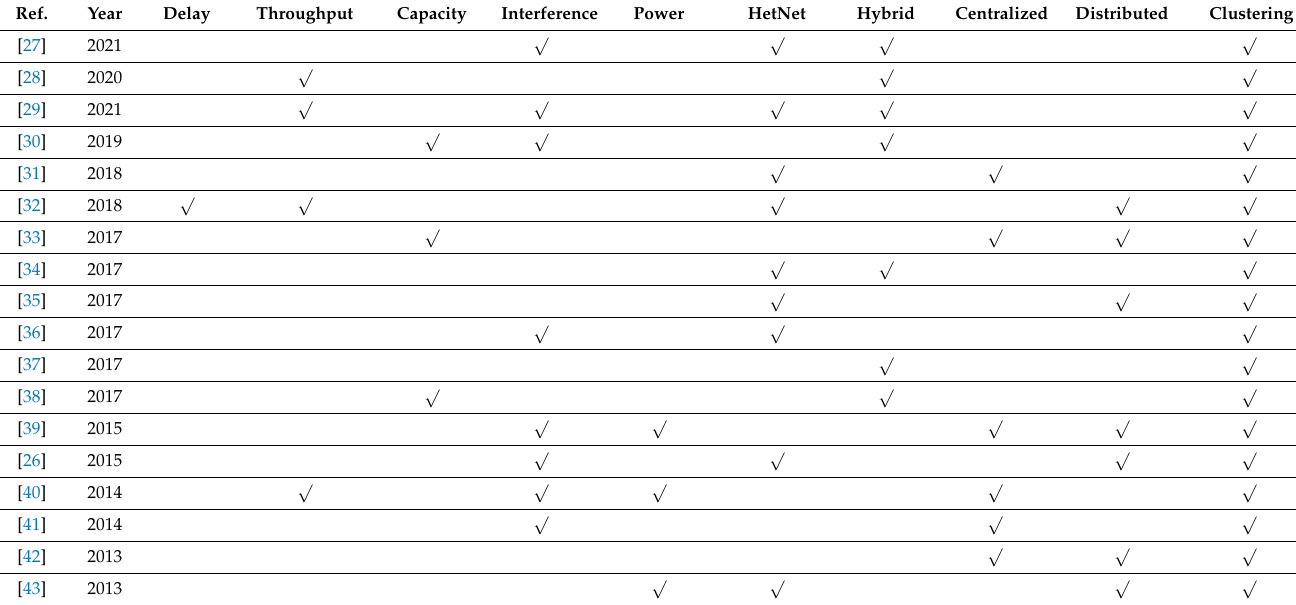
Table 1. Existing work on various clustering